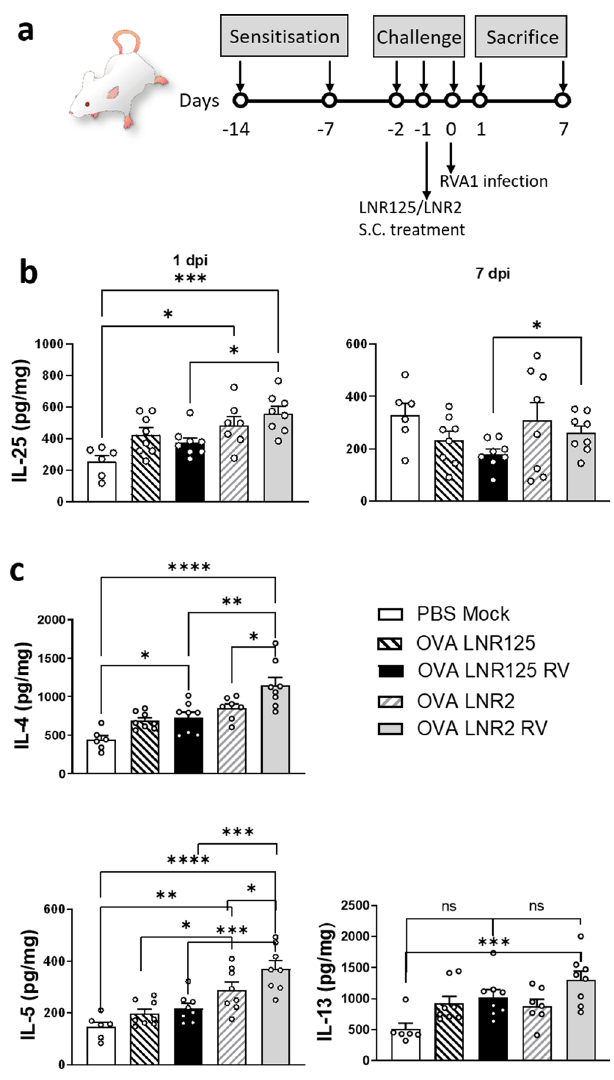
Fig. 5 IL-25 blockade reduced allergic- RV-A1 induced type-2 cytokine induction. Mice were sensitised and challenged to ovalbumin (OVA) and on the second day of challenge, treated with LNR125 or LNR2 intraperitoneally followed by infection with RV-A1, 6 h post fi nal challenge. ( a ) Schematic of treatment and infection time course. ( b ) Lung IL-25 protein expression at 1- and 7-days postinfection (dpi). ( c ) Lung type 2 cytokine (IL-4, IL-5, and IL-13) protein expression at 1 dpi. Bars represent mean + SEM, n = 6 – 8 mice. * P < 0.05, ** P < 0.01, *** P < 0.001, ns = not signi fi cant by 1-way ANOVA with Holm-Sidak ’ s correction for multiple